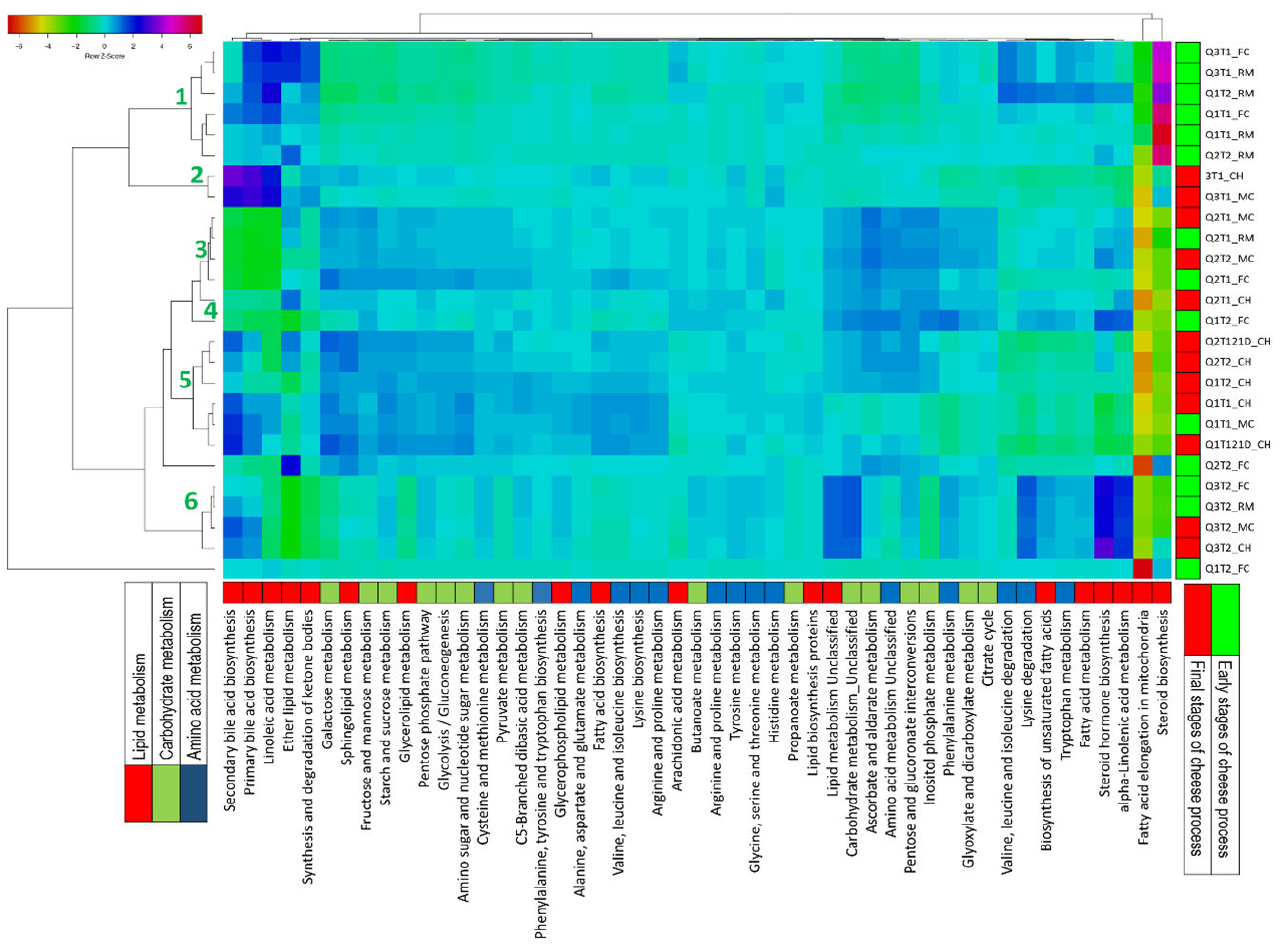
Figure 4. Heap plot representation of the predicted metabolic profiles related to carbohydrate, amino acid, and lipid metabolism in Adobera cheese samples from different cheese factories (CH1, CH2 and CH3) and two seasons of the year (T1 = Dry season, T2 = Rainy season) at different stages of process (RM = raw milk, FC = fresh curd, MC = matured curd, CH = cheese). CH_21D = cheese 21D after elaboration. Rows and columns were clustered by the centroid linkage method and distances were measured by Pearson’s correlations and represented by colors according to the degree of correlation among samples and the predicted relative frequency of